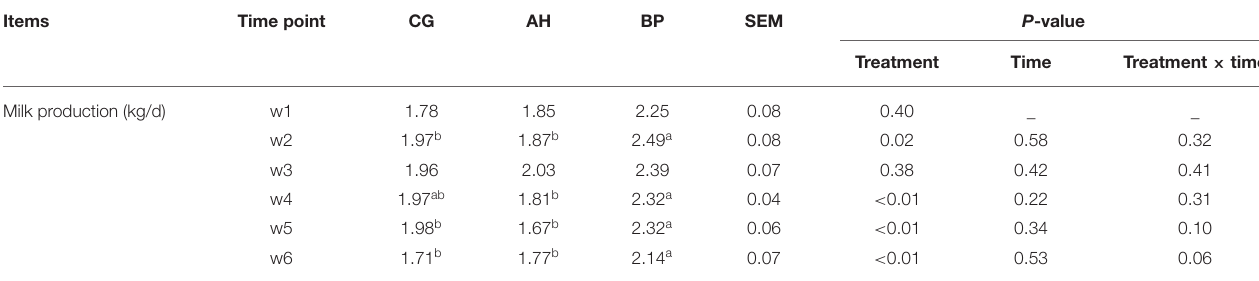
Treatment Time Treatment × time